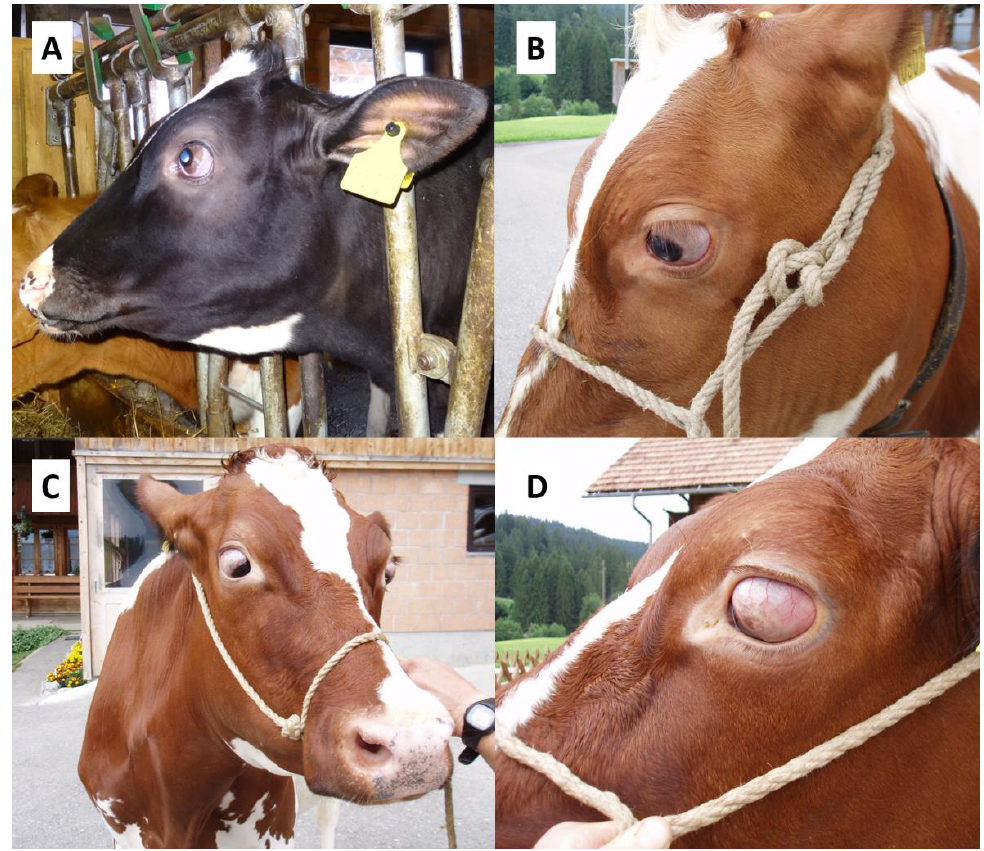
Figure 1. Examples of BCSE-affected Holstein cattle. ( A ) Nine-month old female Holstein heifer with moderate BCSE; ( B ). Eight-month old female Red Holstein heifer with moderate BCSE; ( C , D ) Two-and-a-half year old Red Holstein cow in first lactation with severe BCSE. The first two cases were subjected to histopathological and neuropathological examination.